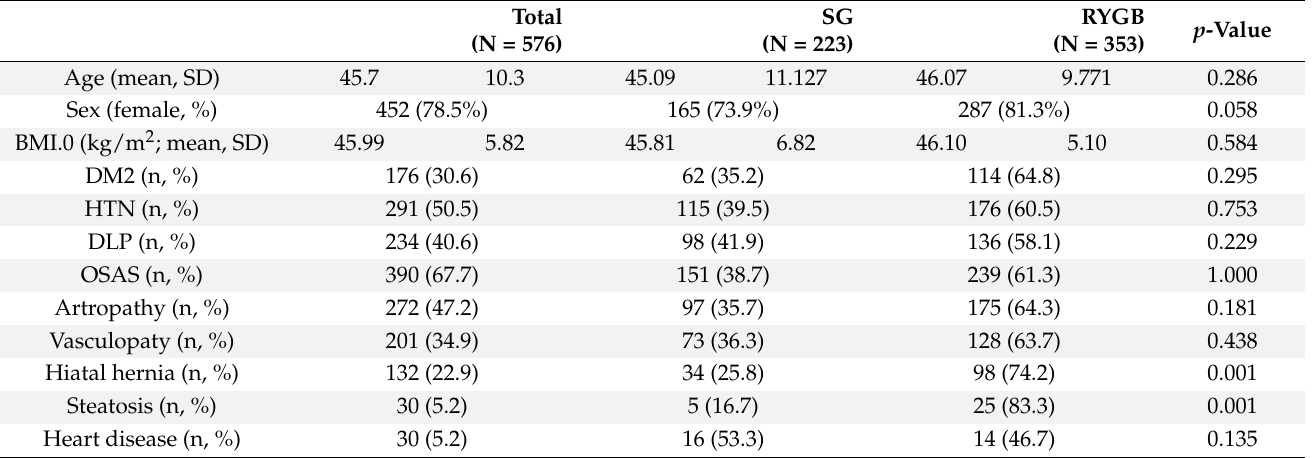
Table 2. Clinical characteristics of the study participants at baseline. Data are expressed as mean ± SD or N number of individuals and % proportion. BMI.O, BMI before surgery; SG, sleeve gastrectomy; RYGB, Roux-en-Y gastric bypass; HTN, hypertension; DM2, diabetes mellitus type 2; OSAS, obstruc- tive apnea syndrome; DLP,